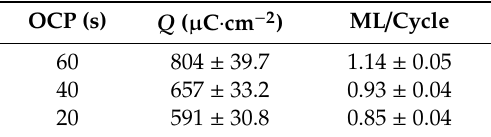
Table 1. Average deposition charge ( Q ) and coverage of UPD-Mn integrated from the curves shown in Figure 3.